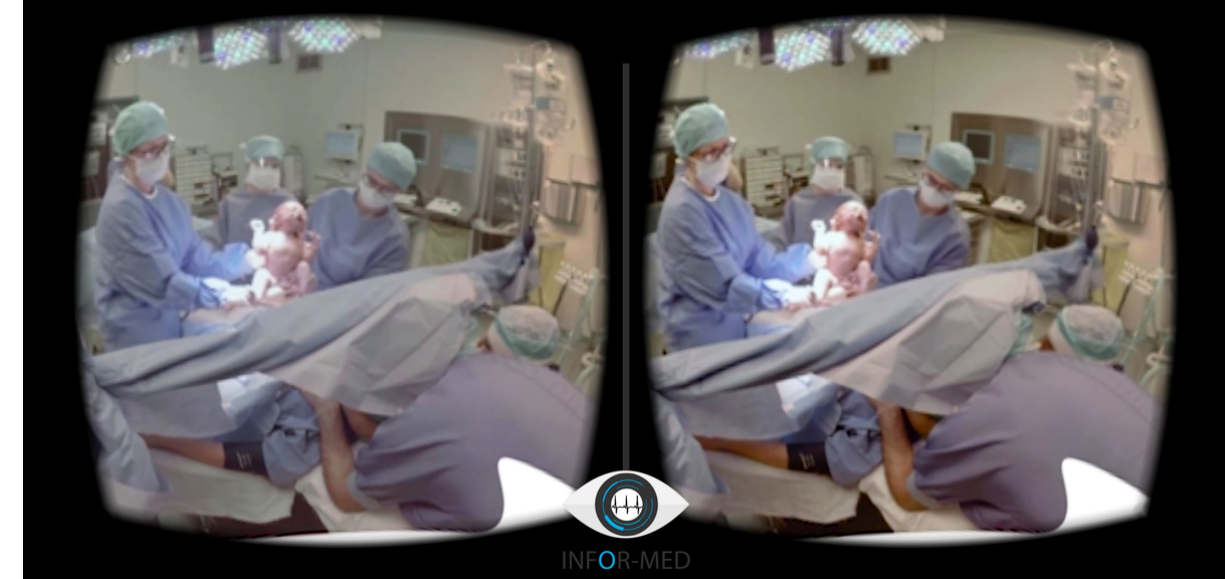
Figure 1. Screenshot from the 360 virtual reality video at the moment of